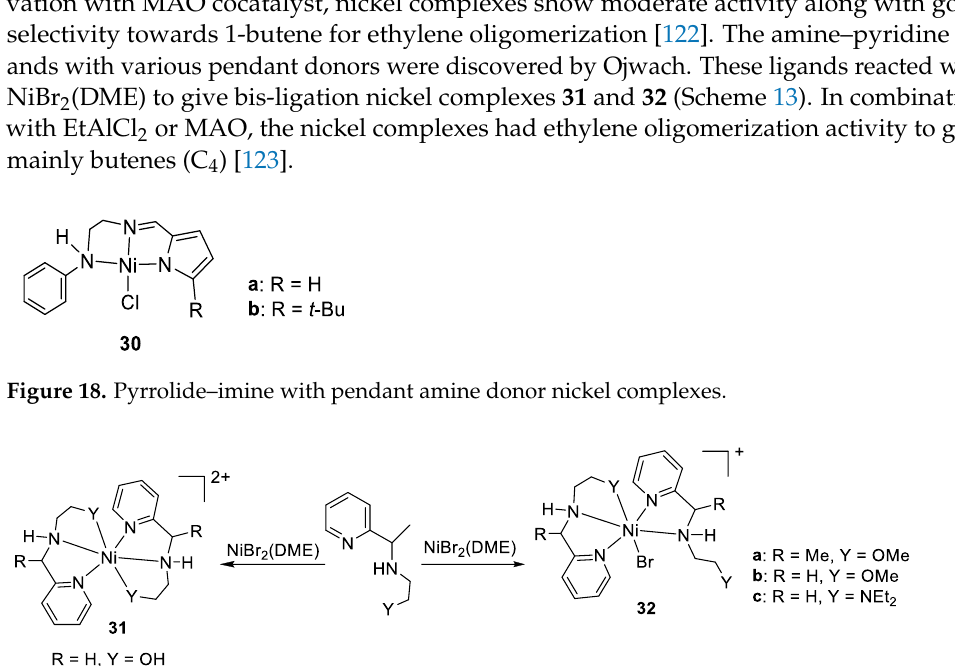
Scheme 13. Amine – pyridine nickel complexes with various pendant donors.